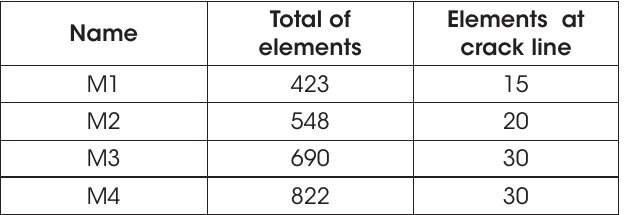
Meshes for the four-point bending test